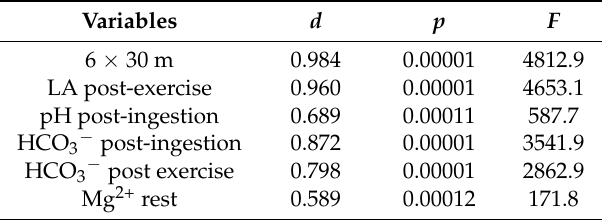
Table 2. Statistically significant differences between baseline and post-intervention period at rest, post ingestion, and after exercise for the experimental